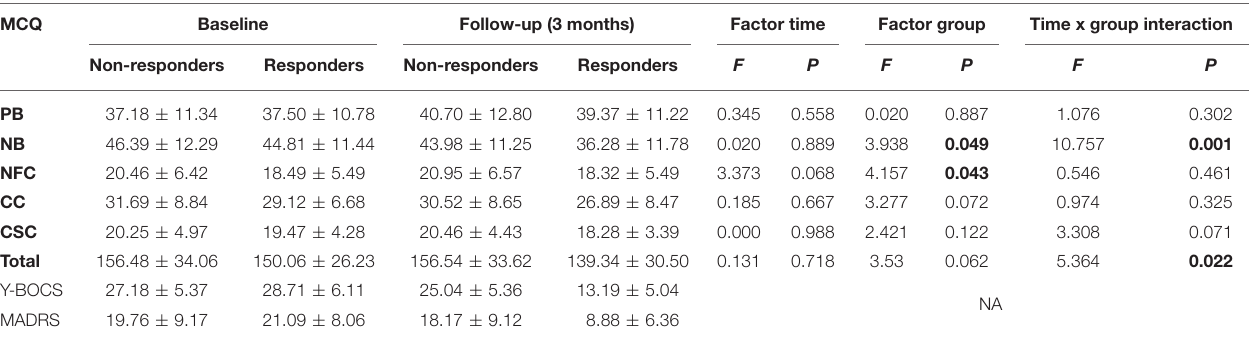
TABLE 4 | MCQ scores at baseline and